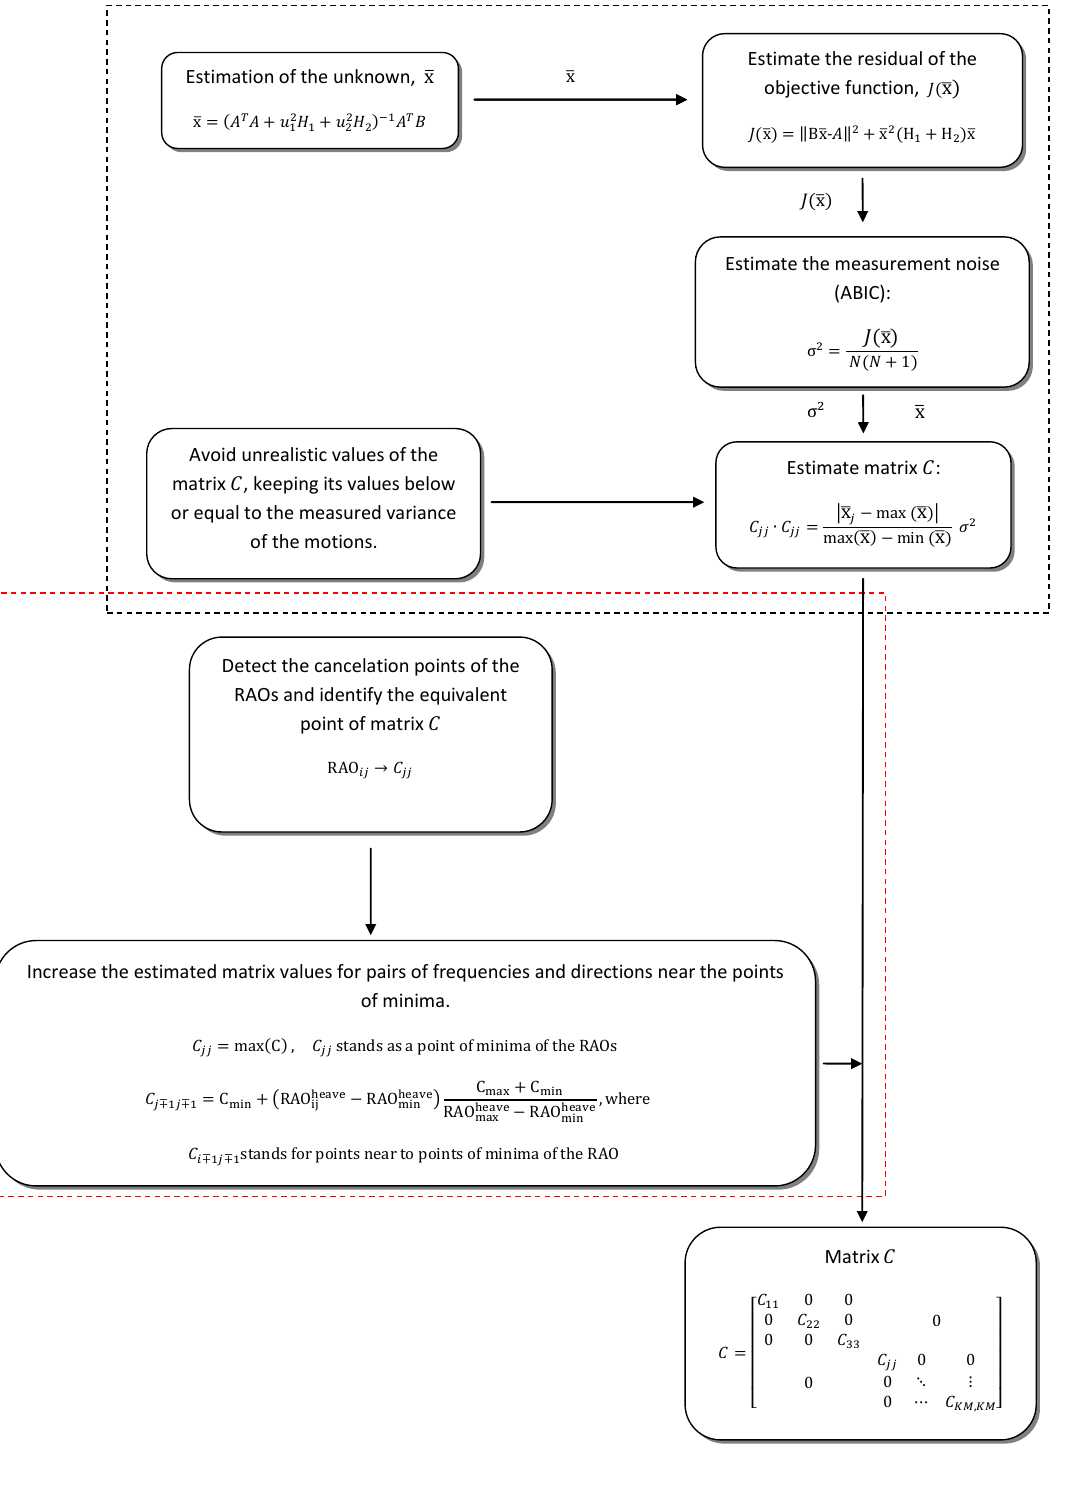
Figure 1. Schematic representation of the algorithm adopted to estimate the matrix C